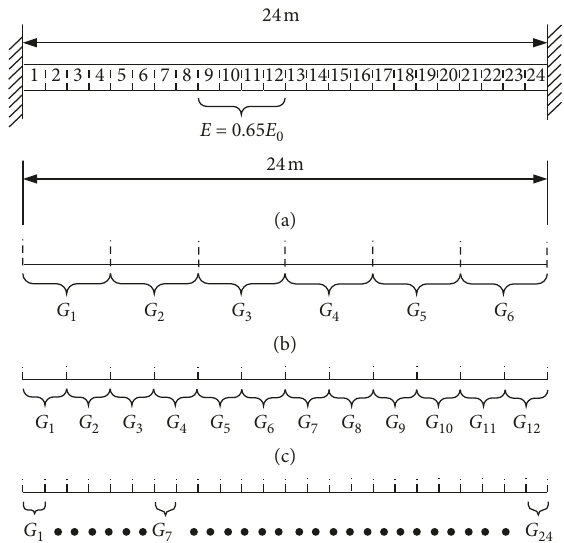
Figure 9: The same damage situation with different sizes of